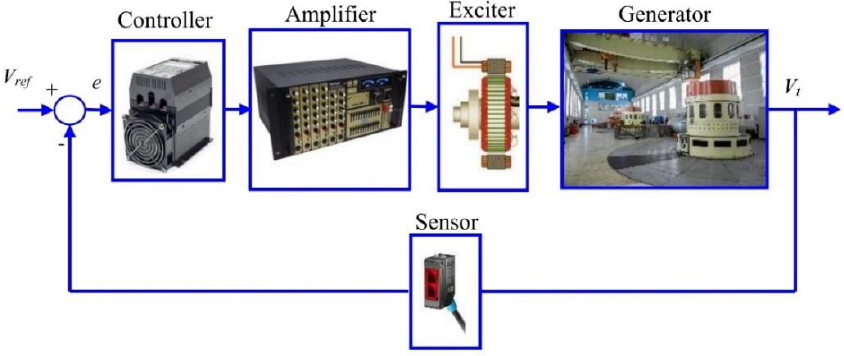
Figure 1. The common structure of the automatic voltage regulator system.